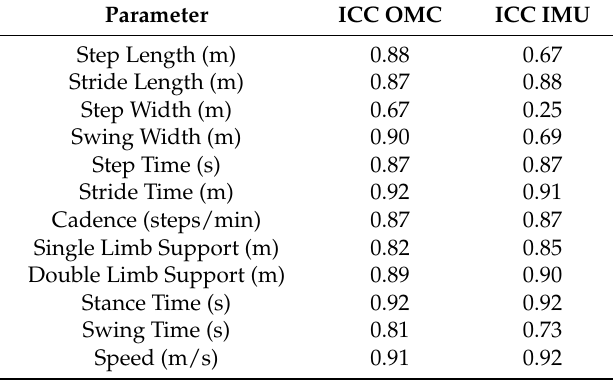
Table 5. Summary of the results of the calculation of the intraclass correlation coefficient for the OMC and IMU system,